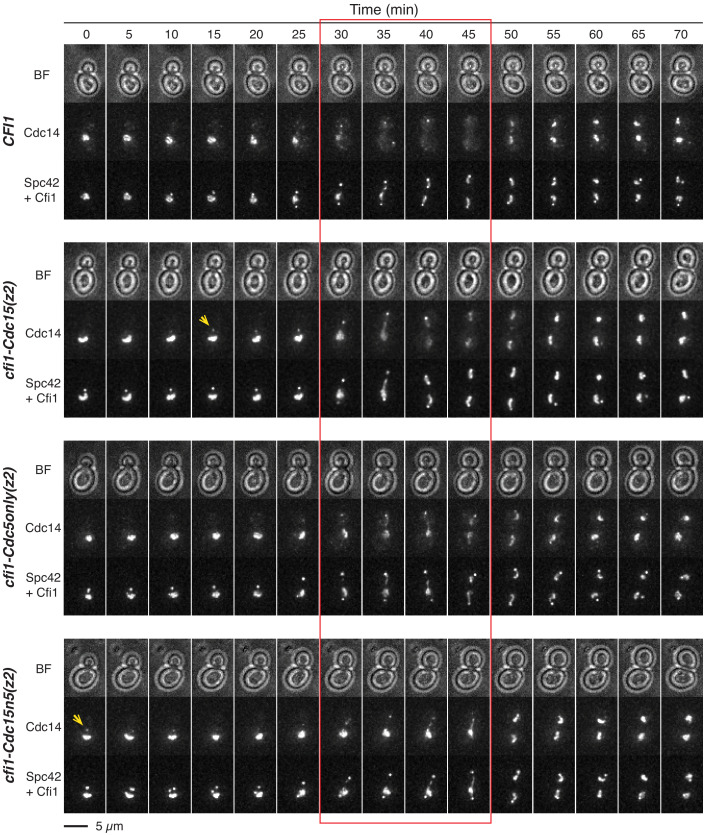
The mitotic exit network (MEN) and CDC5 promote release of Cdc14 from the nucleolus by phosphorylating Cfi1/Net1.Representative images showing Cdc14 nucleolar release kinetics for cells harboring wild-type CFI1/NET1 (A41387) or CFI1/NET1 phospho-mutants for Cdc15 sites (A41587), Cdc5 sites (A441588), and Cdc15 and Cdc5 sites (A41589). Red box highlights anaphase when Cdc14 is fully released in WT cells. Yellow arrows highlight localization of Cdc14 at daughter spindle pole body (dSPB) prior to anaphase.